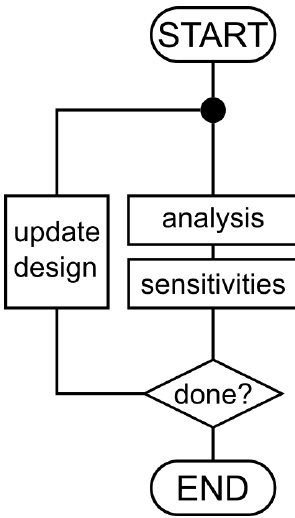
Figure 6. Overview of the optimisation procedure.